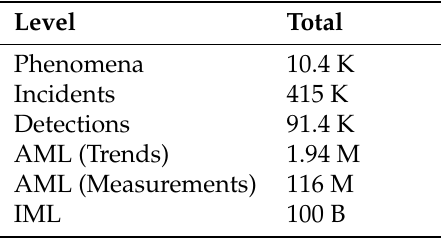
Figure 13. Entities created at each level of the OPQ Information Architecture during the pilot study.